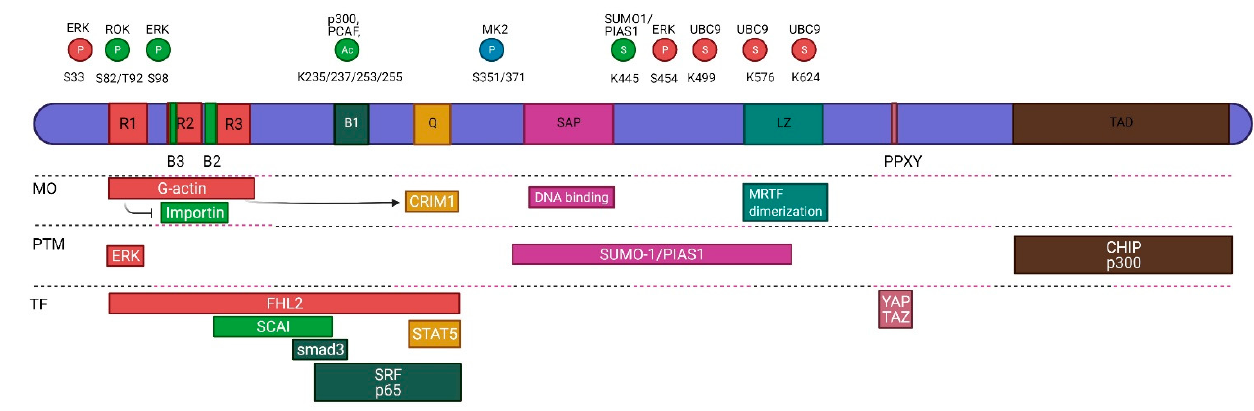
Figure 2. Schematic of MRTF domain architecture, co-factor interaction, and posttranslational modification. MRTFs contain 3 N-term RPEL domains (R1–3) enabling actin binding, 2 interspersed basic amino acid regions (B3, B2) containing the nuclear localization sequence (NLS); Leucine Zipper (LZ) which is necessary for MRTF dimerization and MRTF/SRF-dependent